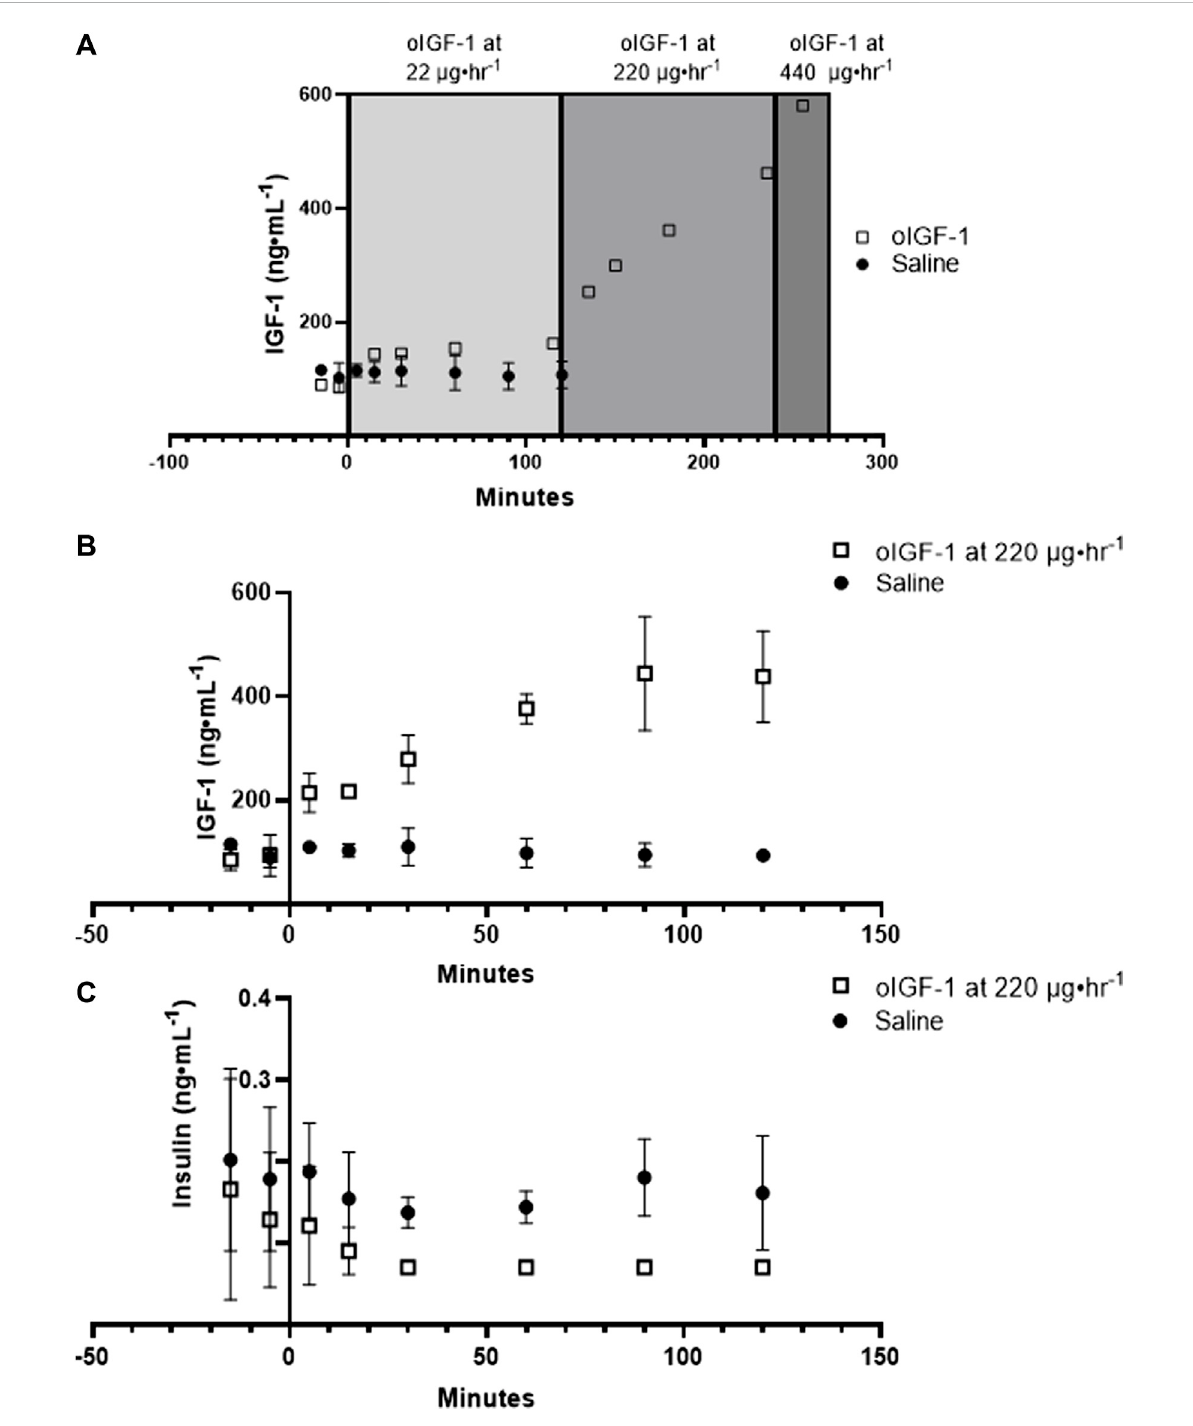
FIGURE 3 Fetalconcentrations ofrecombinantovineIGF-1(oIGF-1) andinsulin. (A) DoseresponsecurveshowingfetalplasmaIGF-1concentrationsafter infusion ofoIGF-1into asingleton fetus(open squares,n= 1)at22,220,and440 μ g · h − 1 .Fetal plasmaIGF-1 concentrationsarealso shown after fetal infusion of saline (closed circles, n = 3) for reference. (B) Fetal plasma IGF-1 and (C) insulin concentrations after fetal infusion of either oIGF-1 at 220 μ g · h − 1 (open squares, n = 2) or saline (closed circles n = 2) into twin